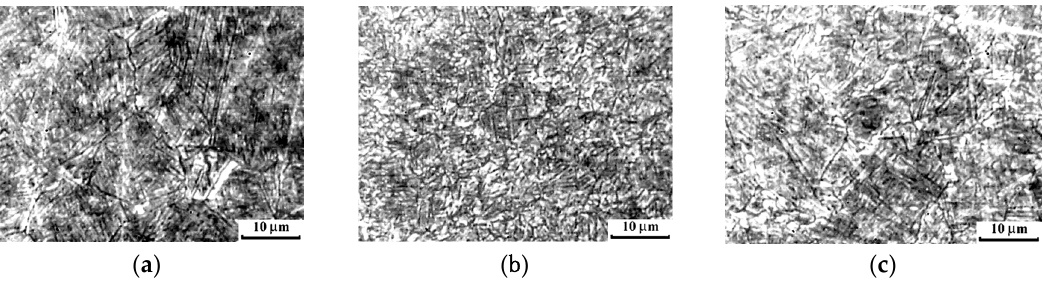
Figure 3. Microstructure of Ti-Al-Mo-V alloy in the initial state before radial forging: center of the workpiece ( a ), surface layer ( b ), transition layer ( c ).